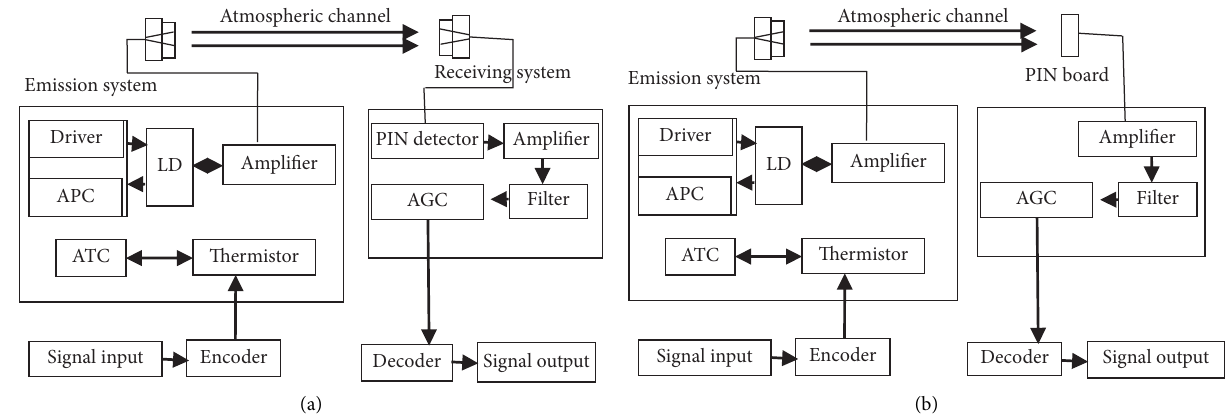
Figure 1: The space optical communication system: (a) the typical system; (b) the new